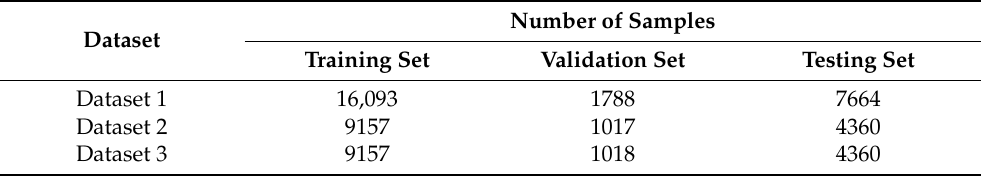
Table 6. Number of samples in training set, validation set, and testing set of the reconstructed